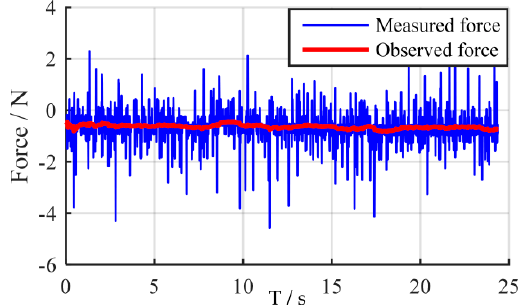
Figure 3. An implementation example of the contact force observer.